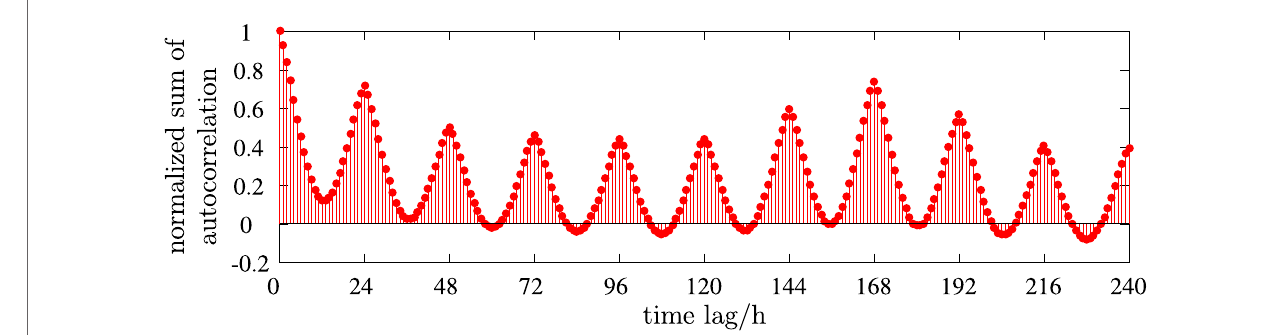
FIGURE 6 | Normalized sum of autocorrelation function (equation (7)) with a time lag of 0–240h.